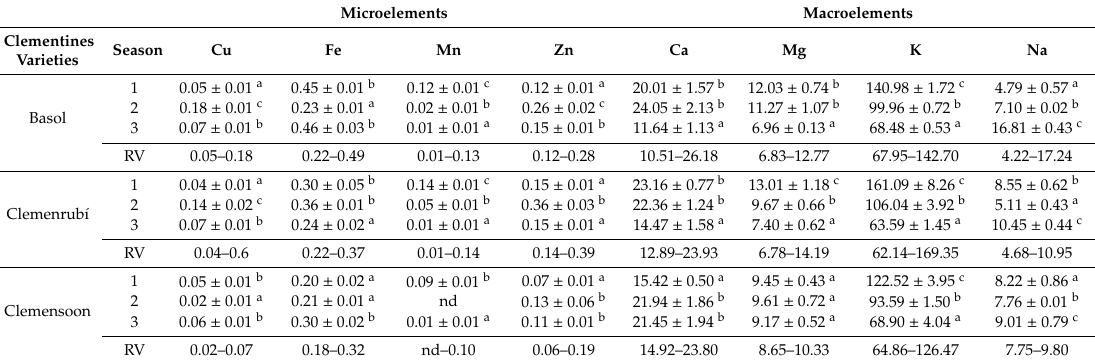
Table 5. Micro and macro elements (mg / 100 g fw of fruit edible portion) in extra early clementine varieties (mean ± SD, n =